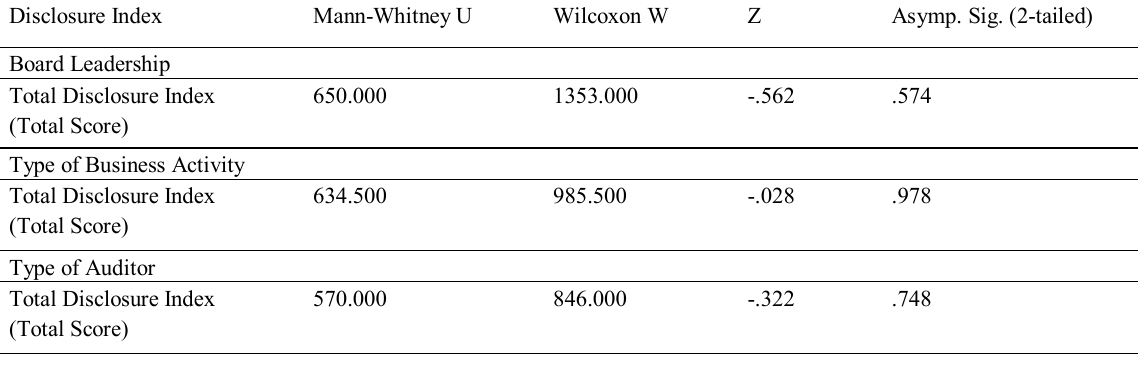
Table 4. Mann-Whitney U Test Results for Categorical Independent